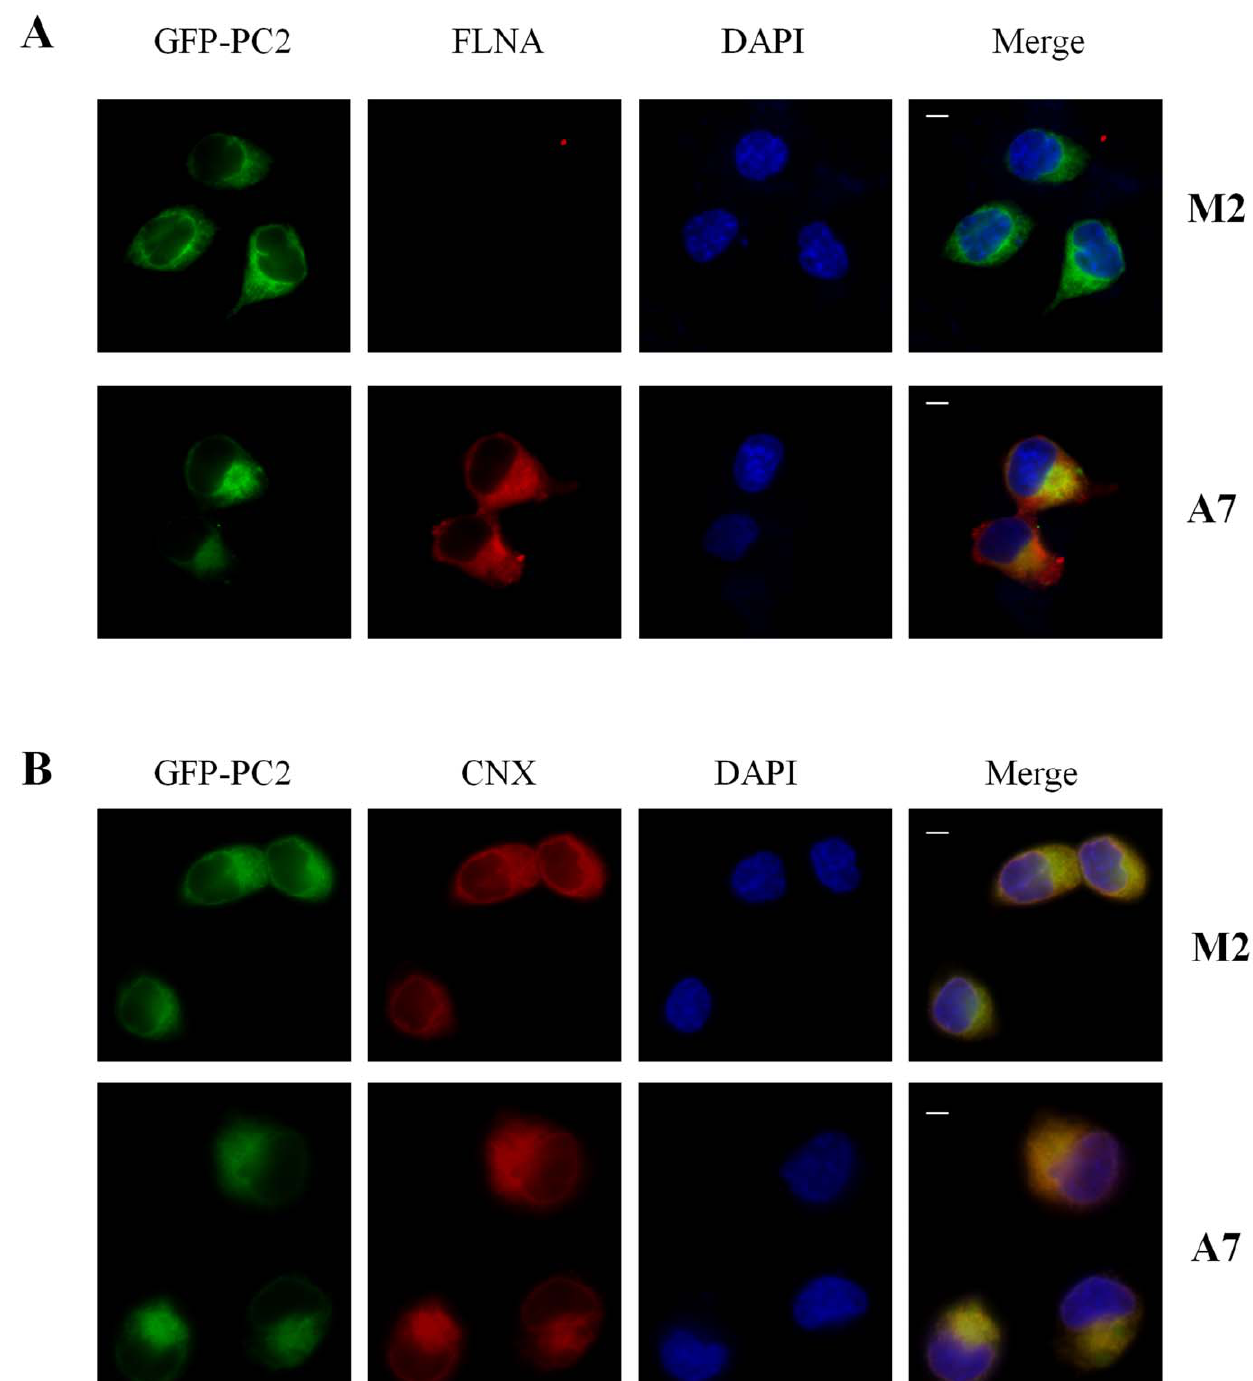
Figure 4. Cellular localization of PC2. M2 and A7 human melanoma cells over-expressing GFP-PC2 were grown on coverslips and incubated at 4 u C overnight after fixation, with either anti-FLNA E-3 or anti-calnexin primary antibodies. The length of the white bar is 20 m m. ( A ) Subcellular co- localization of PC2 and FLNA. ( B ) Subcellular co-localization of PC2 and the ER marker calnexin (CNX).